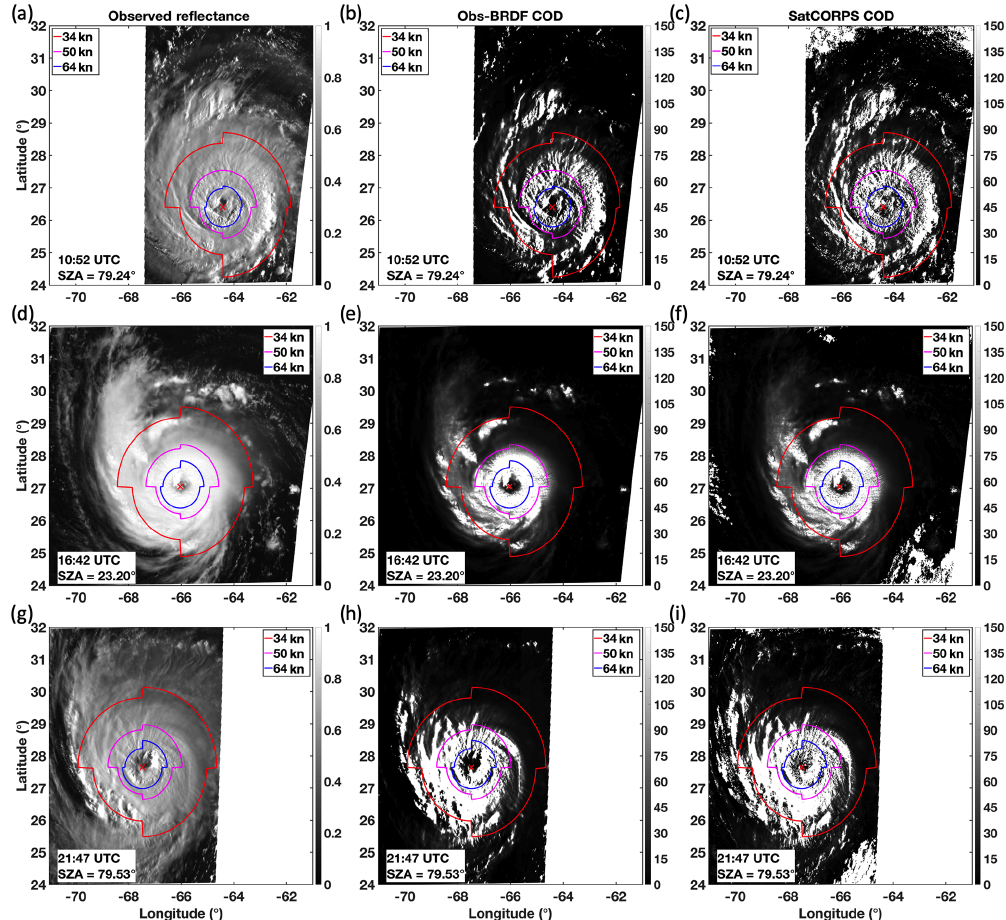
Figure 13. Observed VIS reflectance (a, d, g) , Obs − BRDF COD (b, e, h) , and SatCORPS COD (c, f, i) imagery of Hurricane Florence from GOES-16 on 11 September 2018 at 10:52 (a–c) , 16:42 (d–f) , and 21:47UTC (g–i) . Wind radii contours provided by the NOAA National Hurricane Center are indicated at 34, 50, and 64kn, and the storm center is marked with a red “X”. The average SZA within the 34kn radii is displayed at the bottom of each panel. White areas beyond the edge of the image are either unprocessed parts of the domain or are regions with an SZA that is greater than 82 ◦